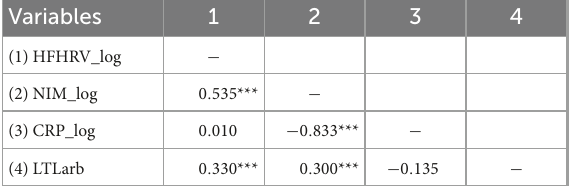
TABLE 4 Partial correlations ( N = 131).